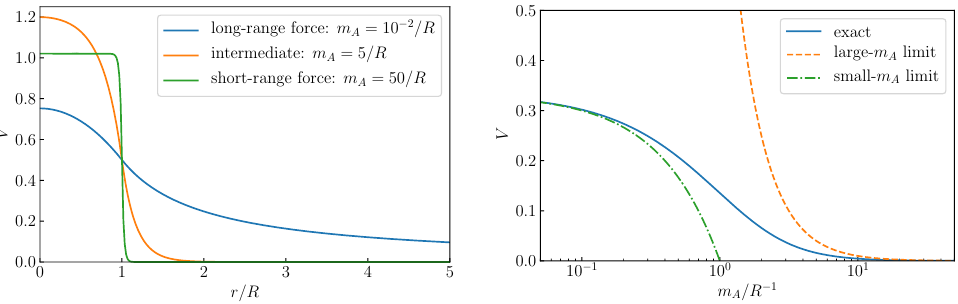
Figure 1 . The e(cid:11)ective potentials V (in arbitrary unit) produced by a sphere of radius R with constant matter density. Left panel : dependence of V on the distance r for di(cid:11)erent values of the mediator mass m A . Values of g (cid:23) g n are chosen in such a way that V ( r = R ) = 1 = 2 for all values of m A . Right panel : comparison of V ( m A ) in the large and small m A limits with the exact result, computed using eqs. (3.5){(3.7) and (3.9){(3.11) at the surface of the sphere ( r = R